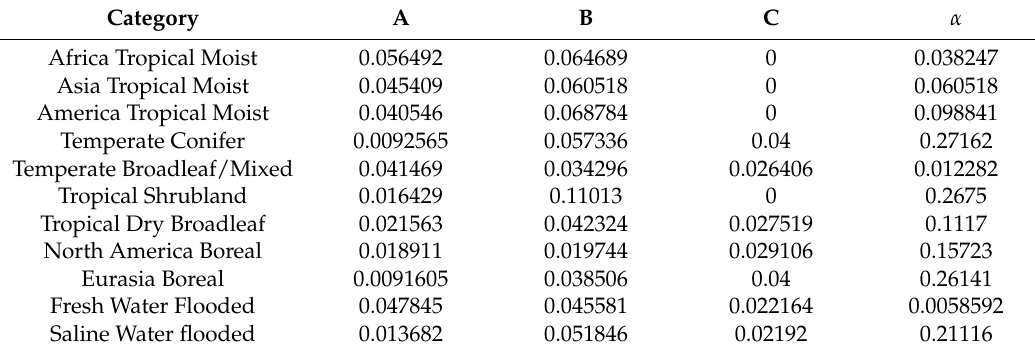
Table 2. Empirically fitted coefficients for correlation between ALOS HV sigma-0 and AGB for various forest types across the globe. The equation follows the form given in Equation (2). Method of determining forest categories is listed in Table 1.